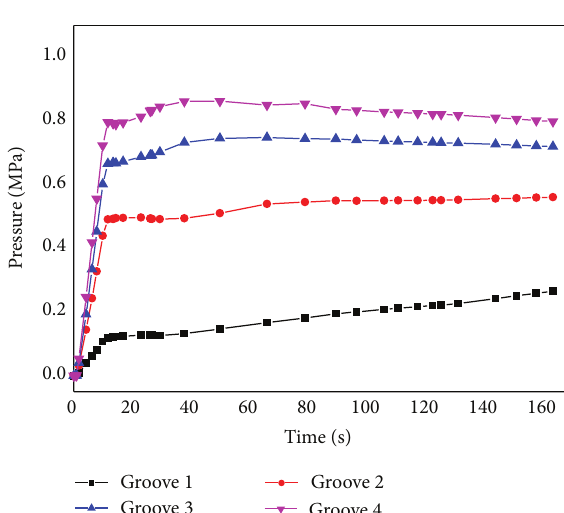
Figure 9: Pressure-time curves of nodes above four grooves.